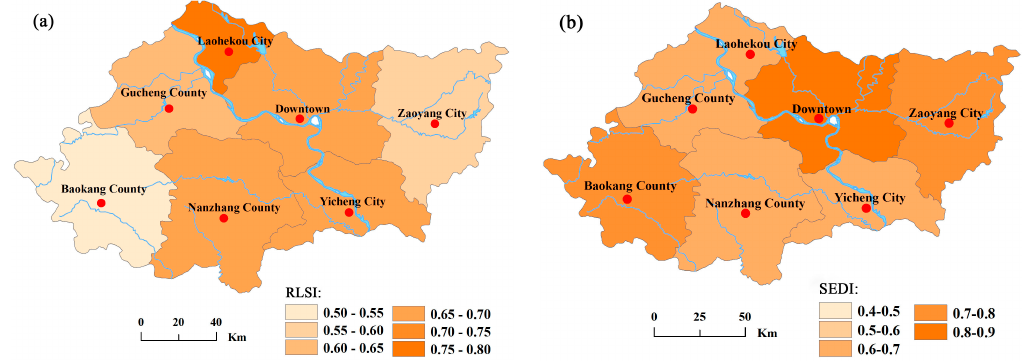
Figure 6. Spatial distribution pattern of RLSI and SEDI in Xiangyang City. ( a ) RLSI; ( b ) SEDI. The red dot is the location of the government.